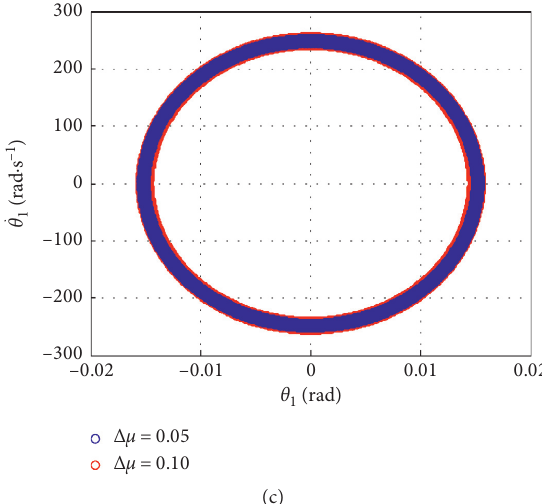
Figure 5: Dispersion of the limit cycles determined with (CHBM +ngPC) with μm � 0.25 (a), μm � 0.35 (b), and μm � 0.50 (c) ( r � 8; Δ V m,i � 0 . 01; Δ μ � 0.05;